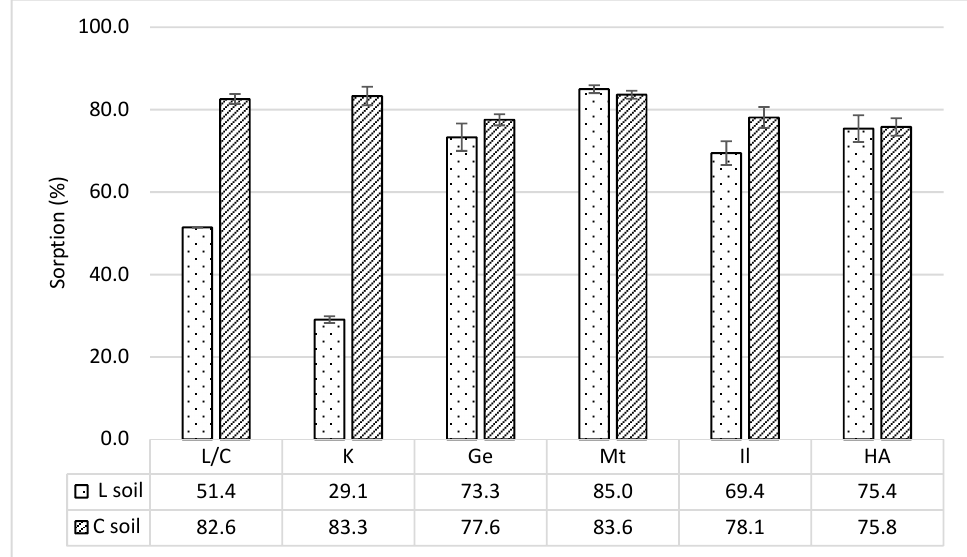
Figure 3. Comparison of metolachlor sorption on soils L and C in the studied variants range. Error bars represent standard deviation of the measurements.